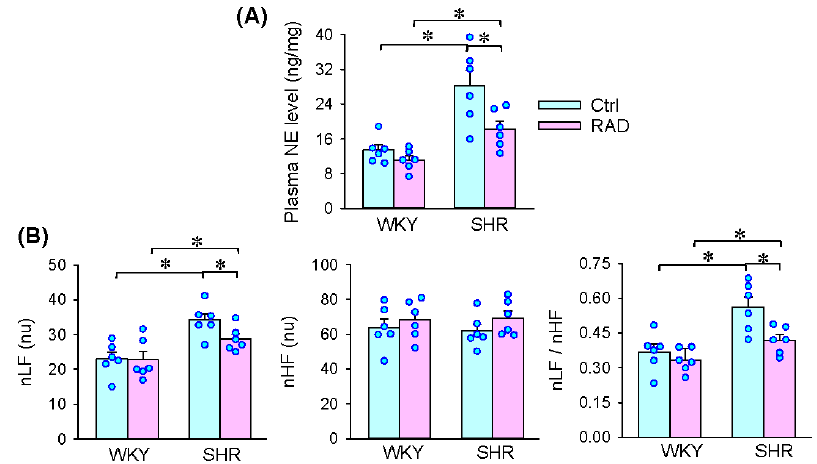
Figure 3. Effects of RAD on the plasma norepinephrine (NE) level and heart rate variability (HRV) in WKY and SHR: ( A ) plasma NE level; ( B ) HRV. nLF, normalized low frequency; nHF, normalized high frequency. Values are mean ± SE. * p < 0.05. n = 6 for each group.